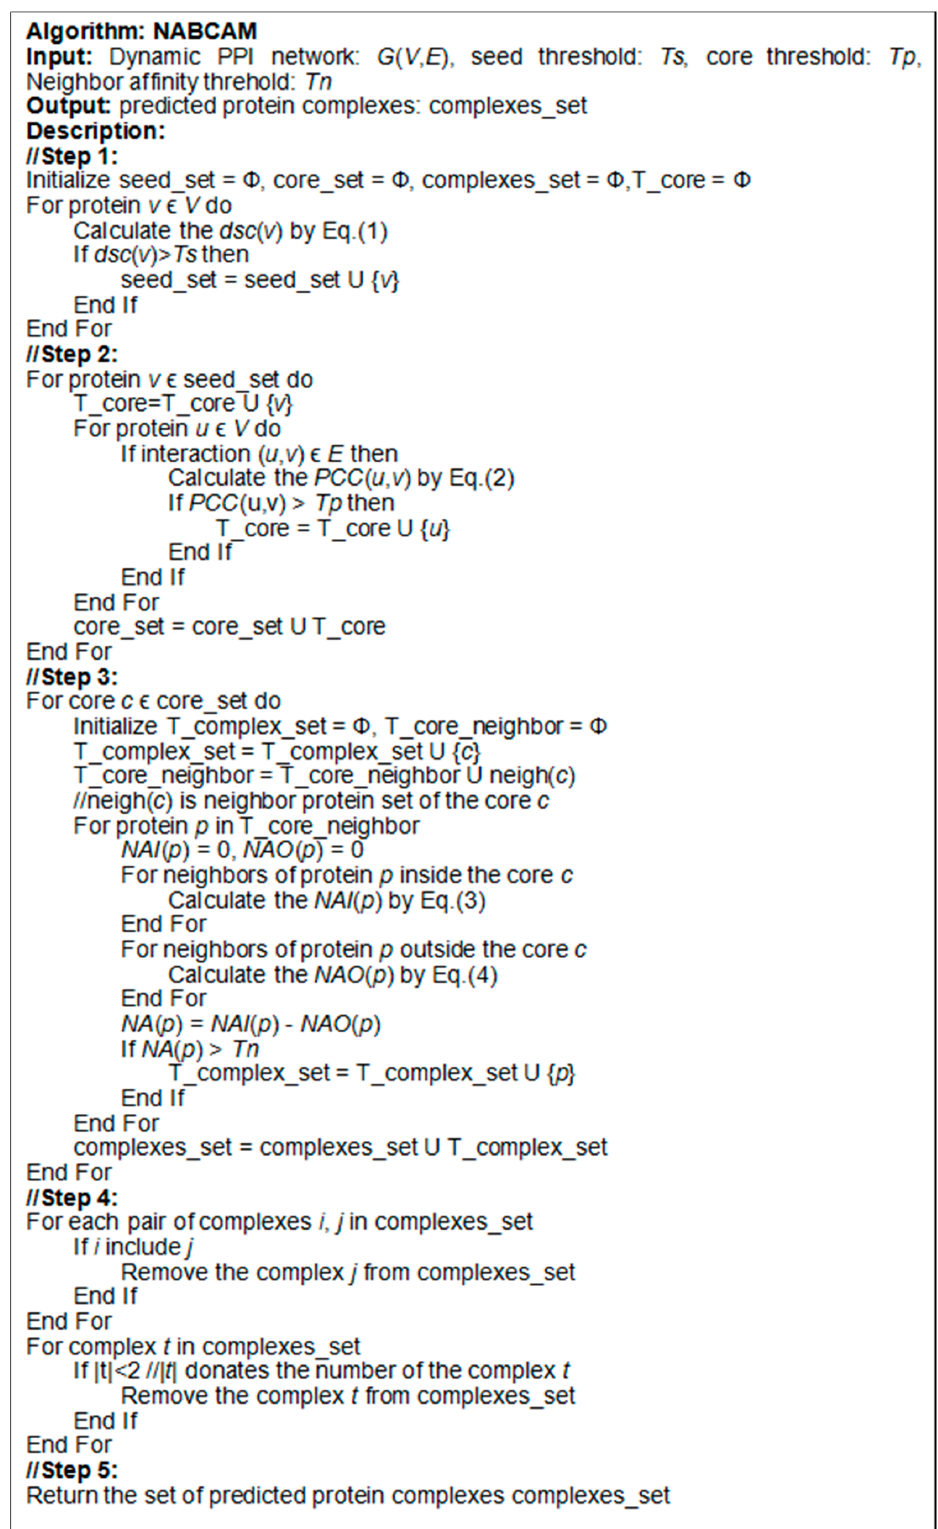
Figure 4. The description of the Neighbor Affinity-Based Core-Attachment Method (NABCAM) algorithm.